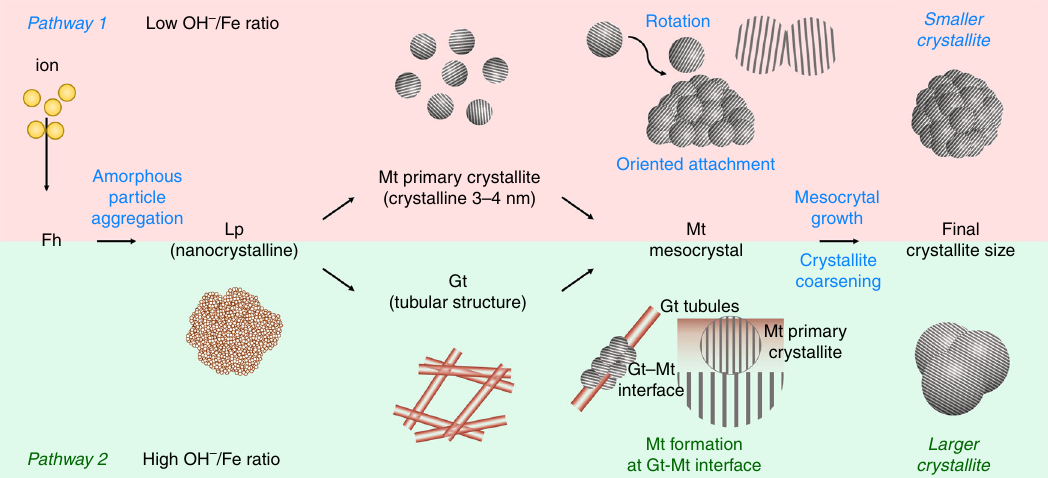
Fig. 1 Schematic illustration of the proposed crystallization model of the Fe 3 O 4 mesocrystal. The two crystallization pathways identi fi ed in this study: Pathway 1 (Fh-Lp-Mt: the growth mechanism of Fe 3 O 4 is oriented attachment), and Pathway 2 (Fh-Lp-Gt-Mt: the growth mechanism of Fe 3 O 4 is interface- controlled growth). Fh: 5Fe 2 O 3 ∙ 9H 2 O, Lp: γ -FeO(OH), Gt: α -FeO(OH), Mt: Fe 3 O 4 but different crystallite sizes ( C ) of 23 and 43 nm (Sample 1 (S1):